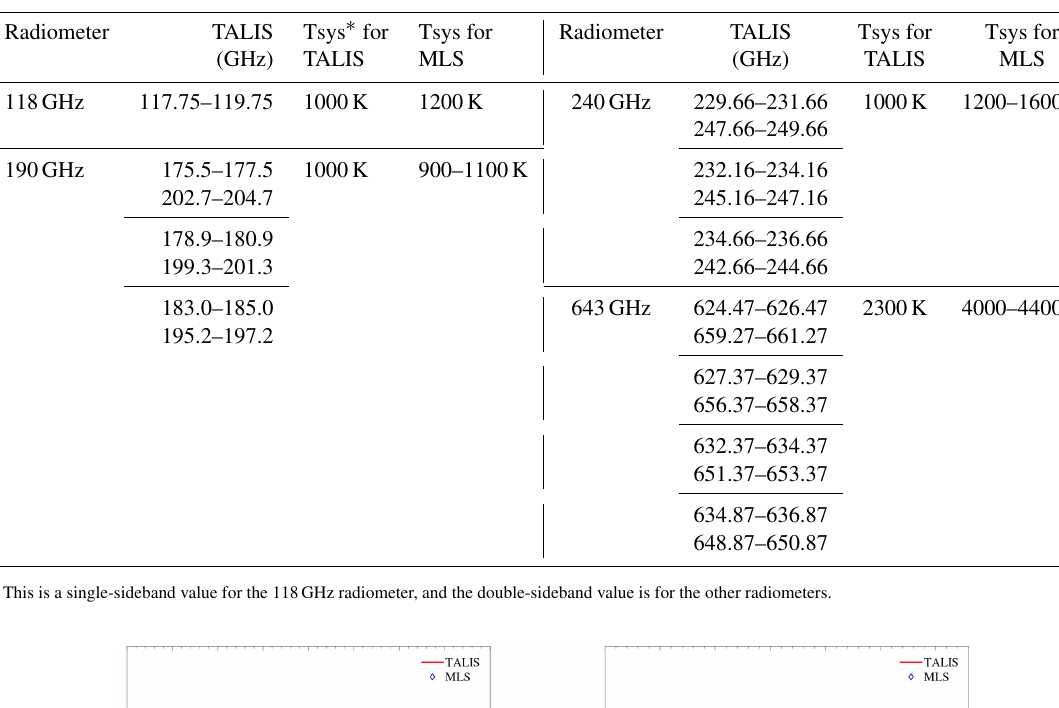
Table 2. Spectral bands and Tsys of TALIS.